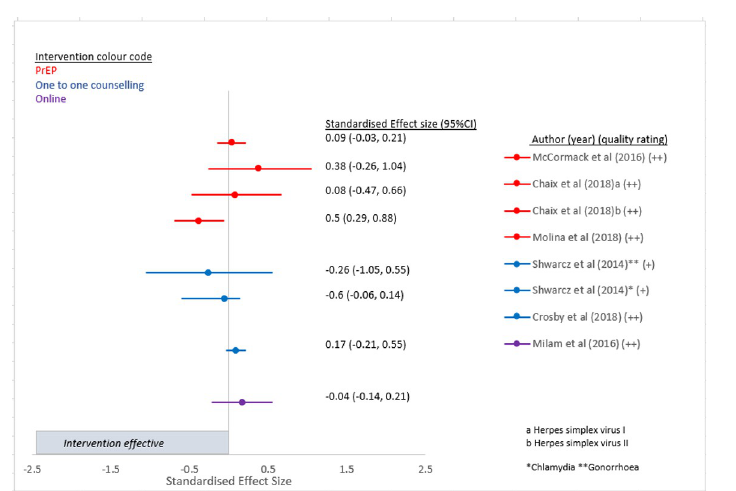
Fig 3. Intervention effect on STI